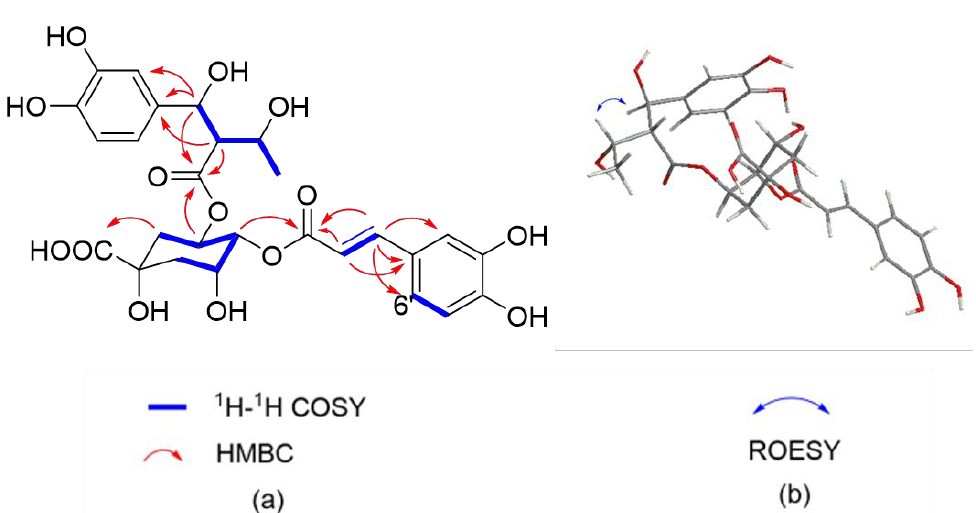
Figure 3. ( a ) 1 H- 1 H COSY and key HMBC correlations of Compound 1 ; ( b ) selected ROESY correlations of compound. Figure 3. (a) 1 H- 1 H COSY and key HMBC correlations of Compound 1; (b ) selected ROESY correlations of compound.